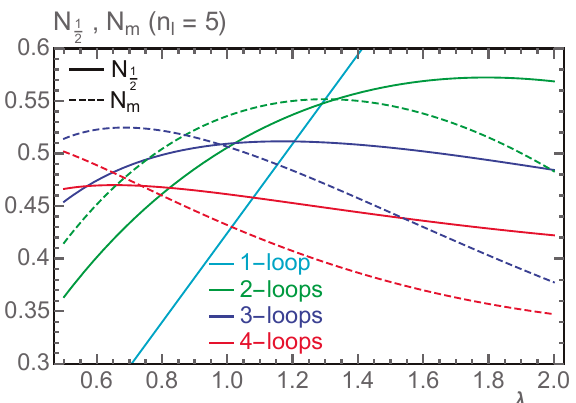
Figure 6. Comparison of N ( n ) and N ( n ) m for n ‘ = 5. Results are shown as a function of (cid:21) including 1 = 2 contributions from one to four